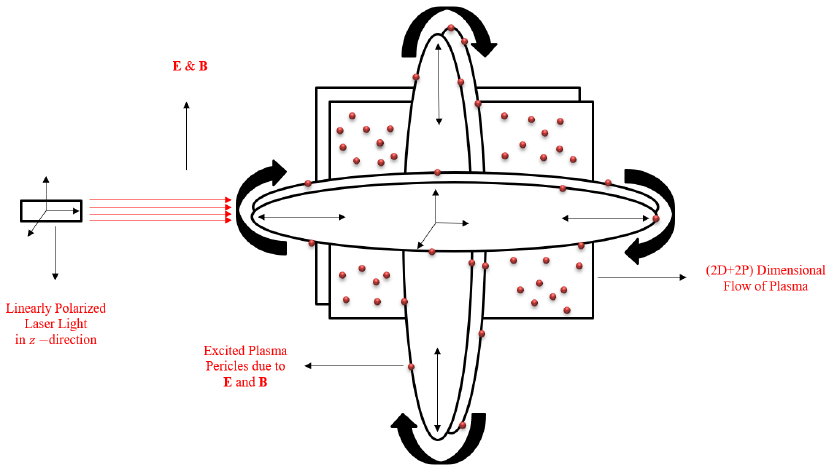
Figure 2. Geometry of the problem.